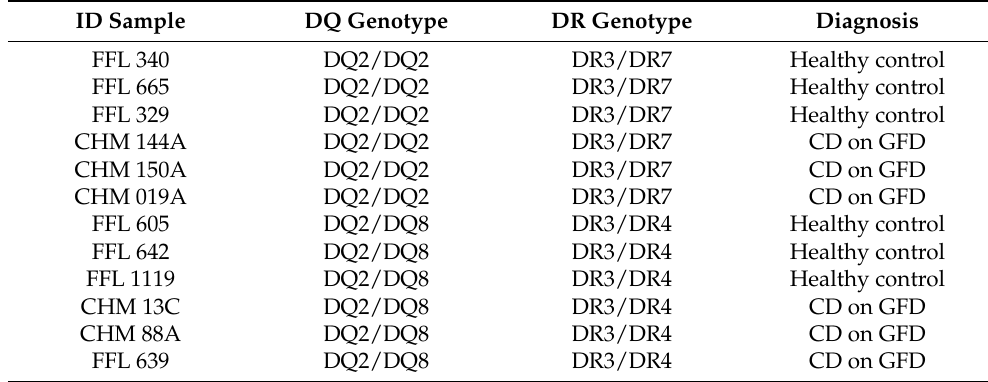
Table 1. HLA-DQ and -DR genotypes of U.S. celiac disease patients following a gluten-free diet (CD on GFD) and healthy controls (HC) chosen for macrophages analysis.